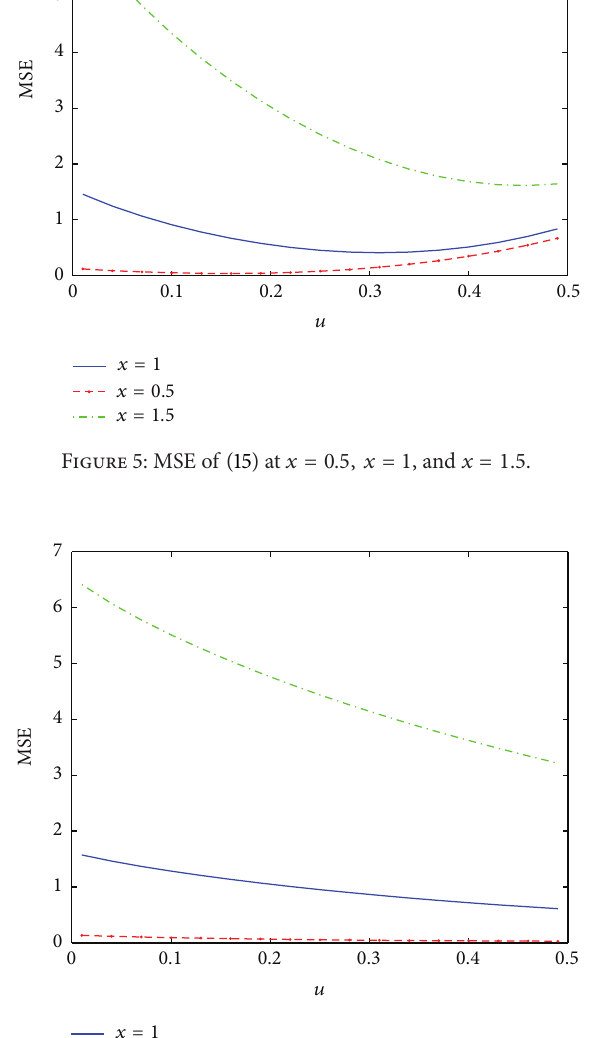
shows the approximate method of the fractional derivative 𝐷 1/5 𝑥 2 using (7). The mean square error is determined for